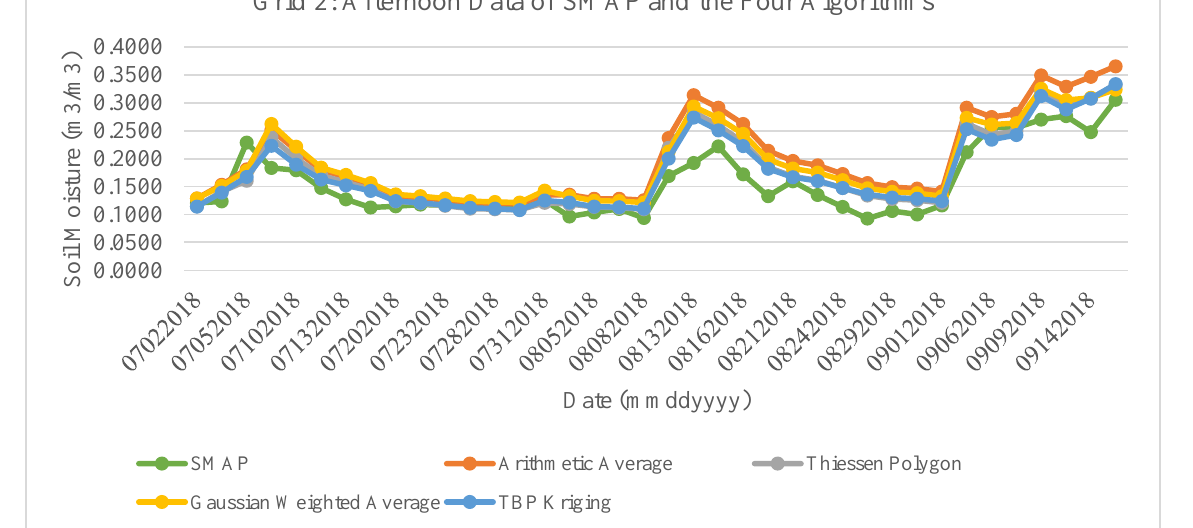
Figure 7. Grid 2 — spatial autocorrelation detected: afternoon soil moisture data plot with SMAP and the four algorithms. Soil moisture was measured at 5 cm depth.